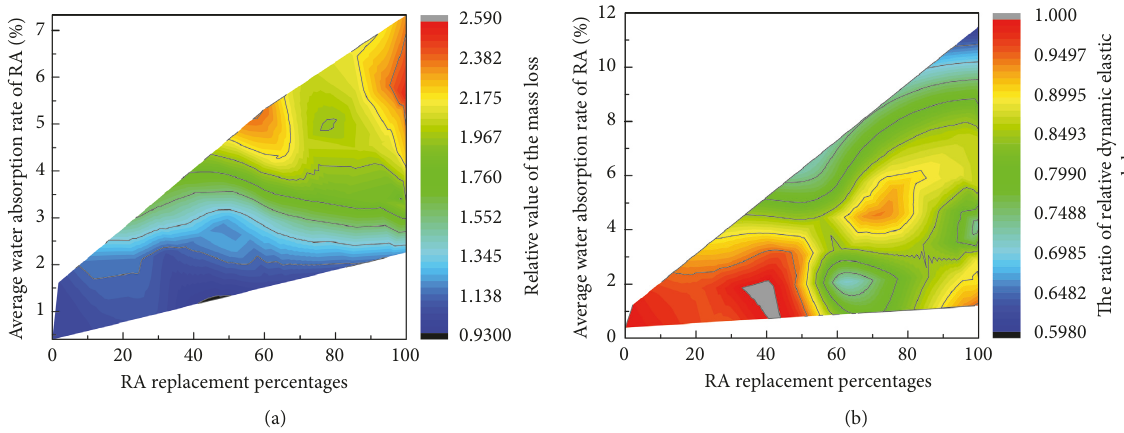
Figure 11: Correlation between the freeze-thaw resistance of RAC, average water absorption rate, and replacement percentages of RA. (a) Mass loss and (b) relative dynamic elastic